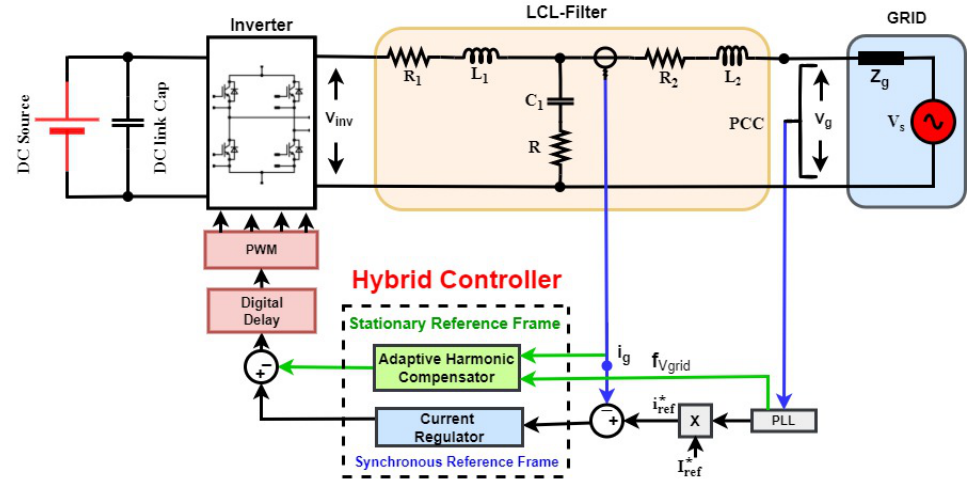
Figure 1. The architecture of proposed grid tied